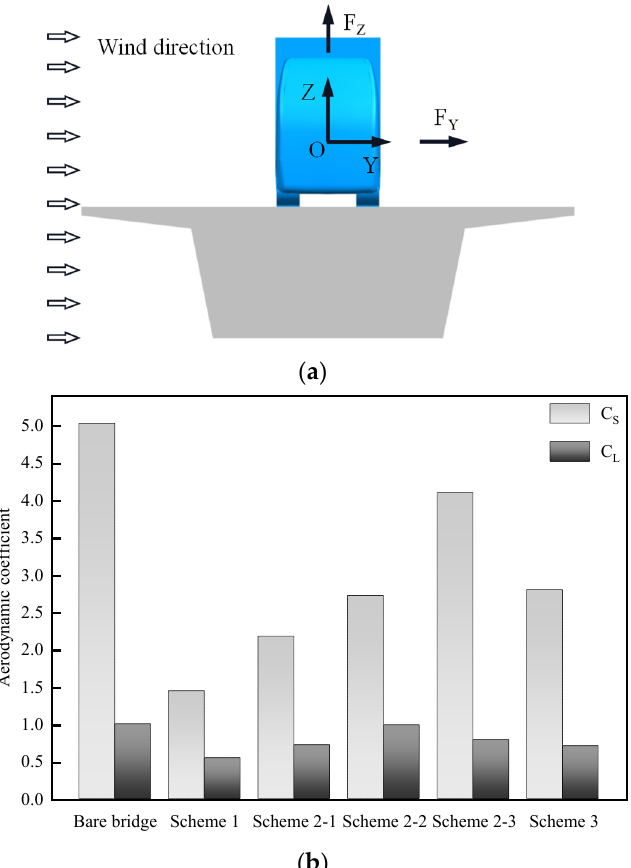
Figure 11. Aerodynamic force definition and variation law (( a ) aerodynamic definition; ( b ) aerody- namic coefficient of different